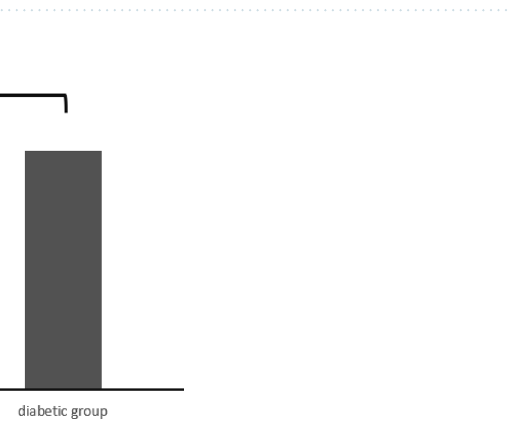
Figure 1. CT (μm) in 17 locations by group after PSM. *Significantly related on the 0.05 level (both sides).